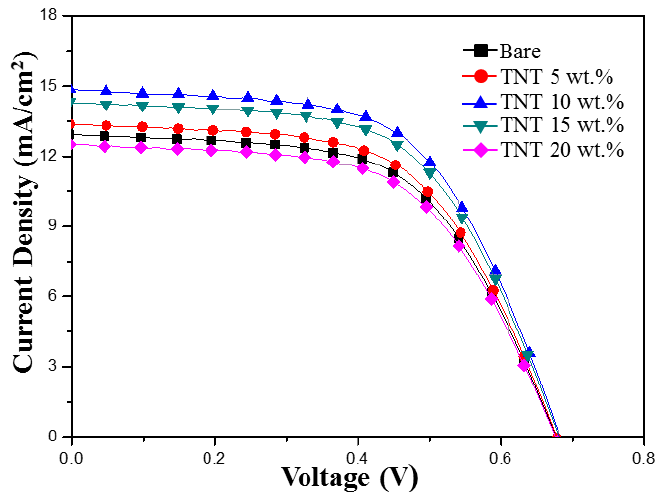
nanoparticle/TNT 2